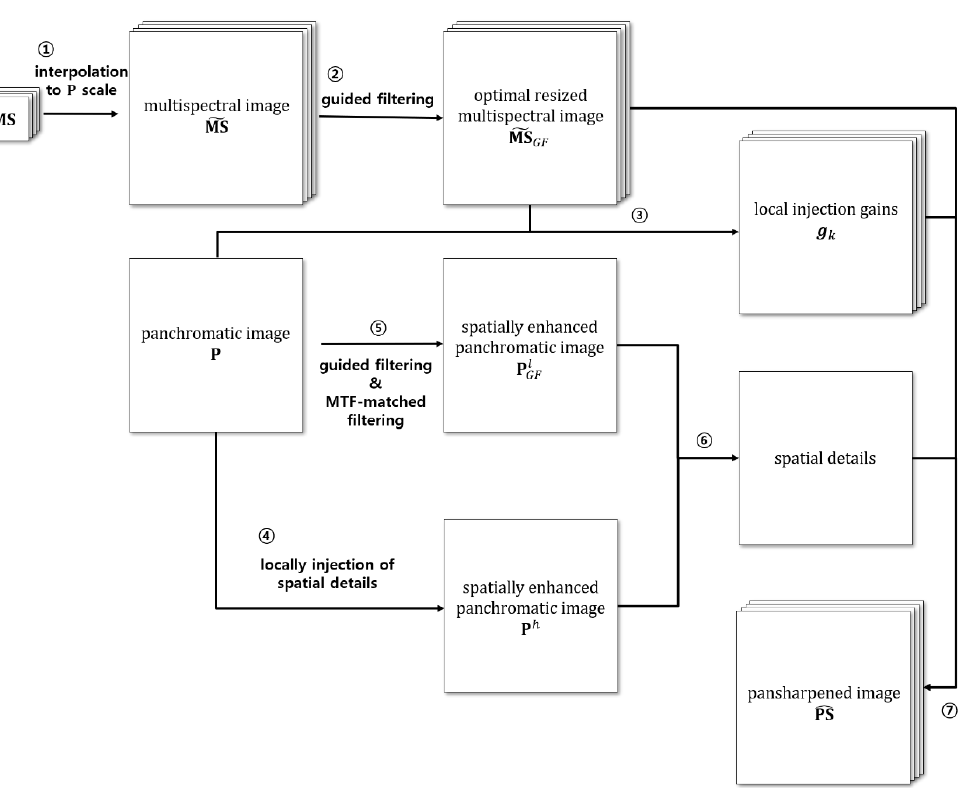
Figure 1. Workflow of the proposed algorithm based on guided filtering (GF).